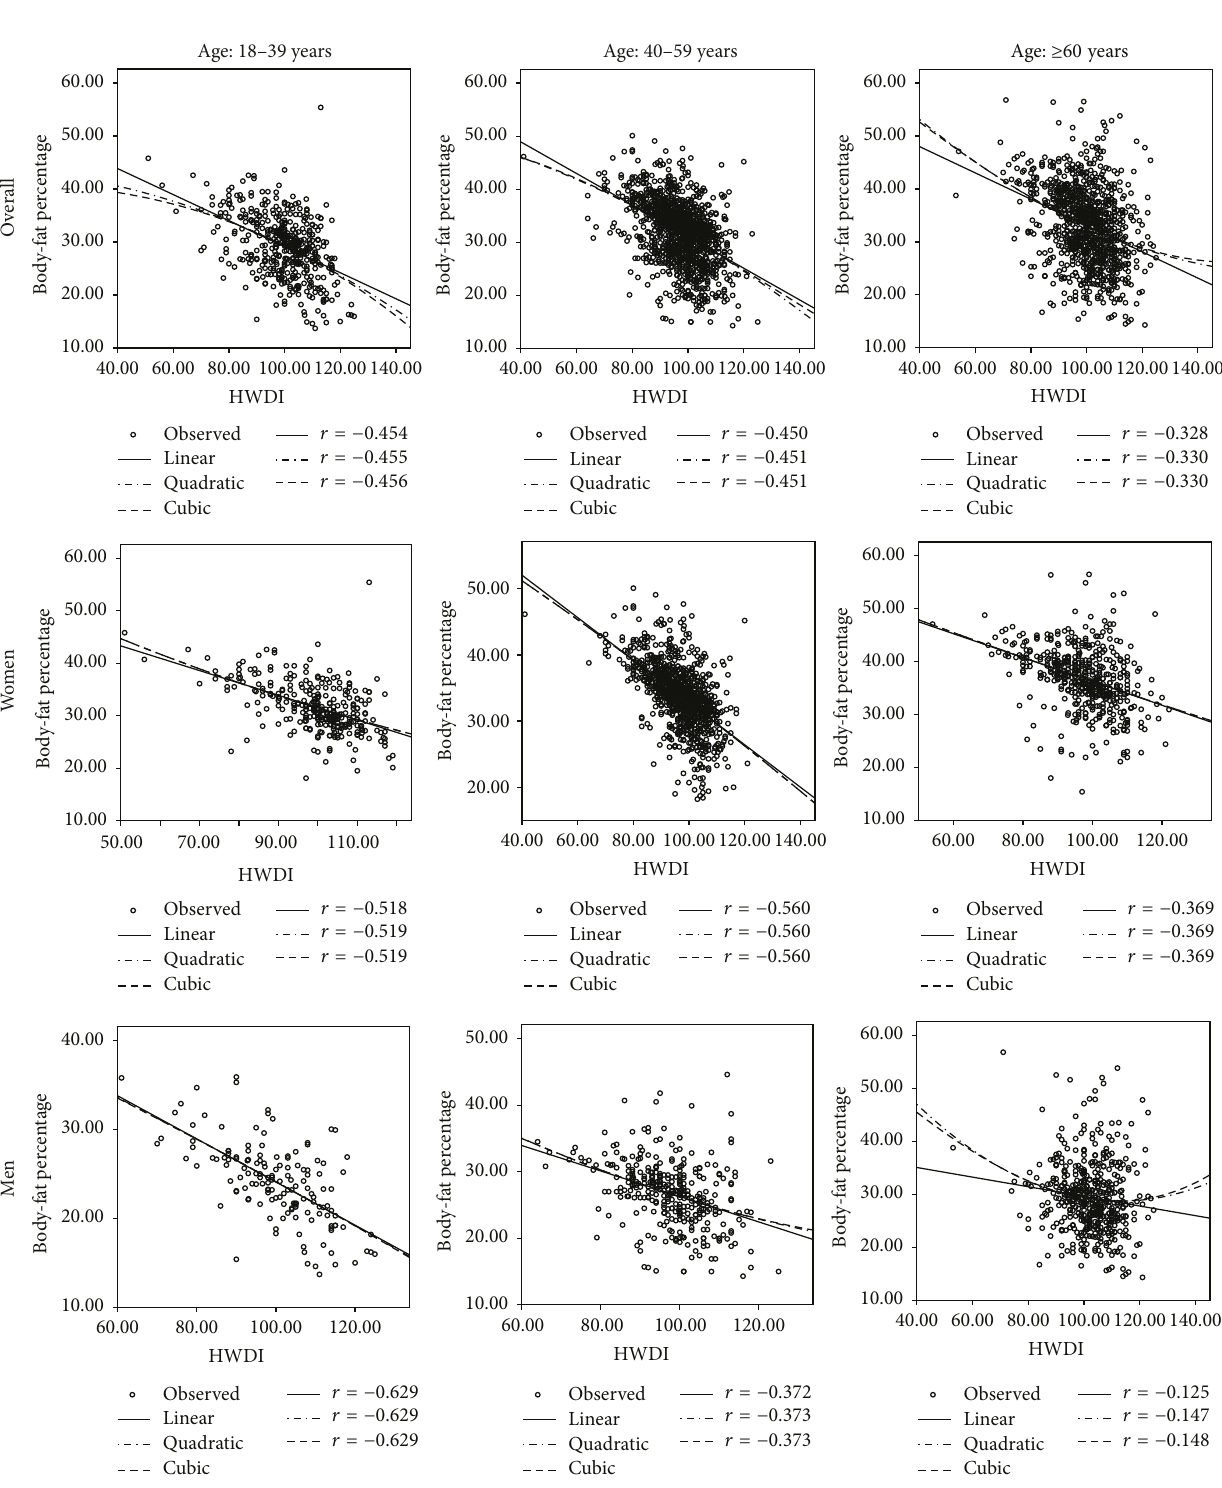
Figure 3: HWDI and body-fat percentage in relation to age and